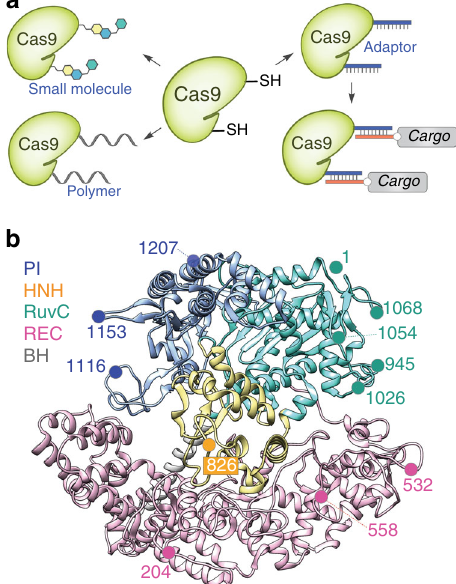
Fig. 1 A conjugation platform for Cas9. a A modular design strategy to functionalize Cas9. b Structure-guided selection of chemical labeling sites. Protospacer adjacent motif-interacting (PI) domain is in blue, HNH domain is in yellow, RuvC domain is in cyan, recognition (REC) lobe is in magenta, and bridge helix (BH) is in grey. Crystal structure of the Cas9-gRNA-DNA ternary complex is used (PDB: 5F9R) 22